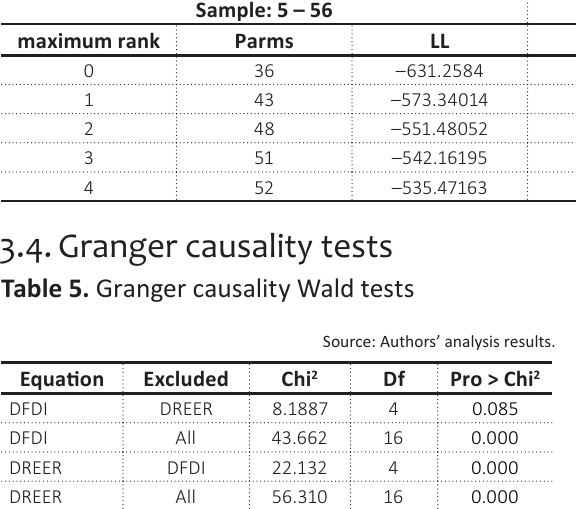
Table 6. Testing results of the relationship between REER and FDI